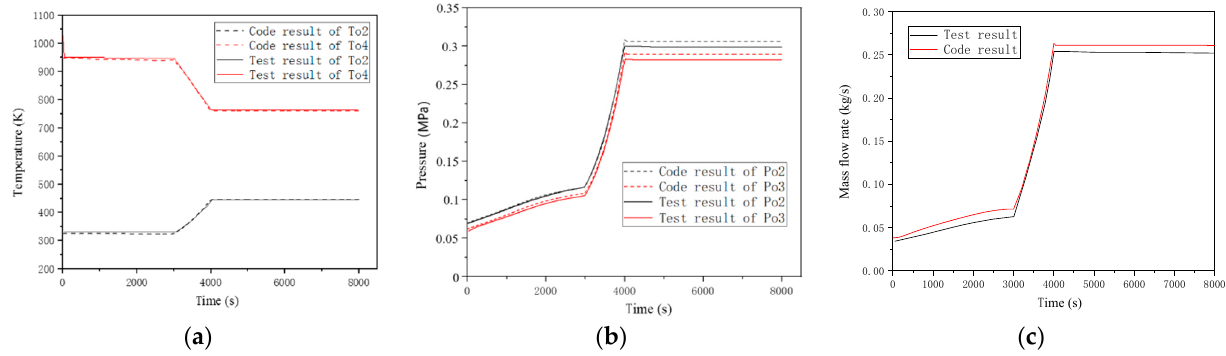
Figure 12. Comparisons between calculated and experimental results of SBL-30 system: ( a ) tempera- ture, ( b ) pressure, and ( c ) mass